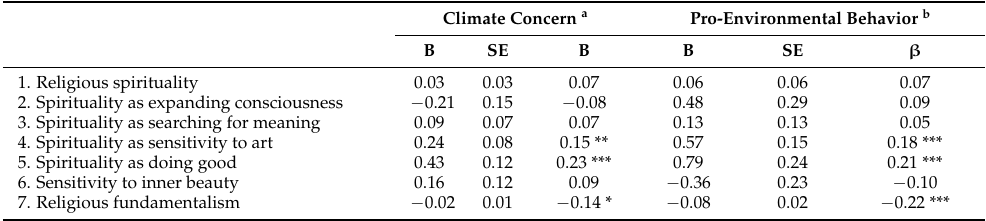
Table 2. Spirituality and religious fundamentalism as predictors of ecological outcomes (N =